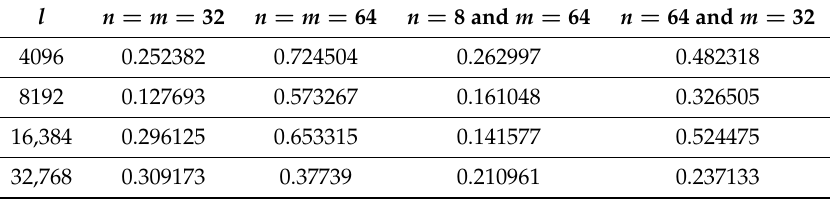
Table 6. p -values of the Shapiro-Wilk test of normality for samples of Z t , in random H i matrices, that satisfy the